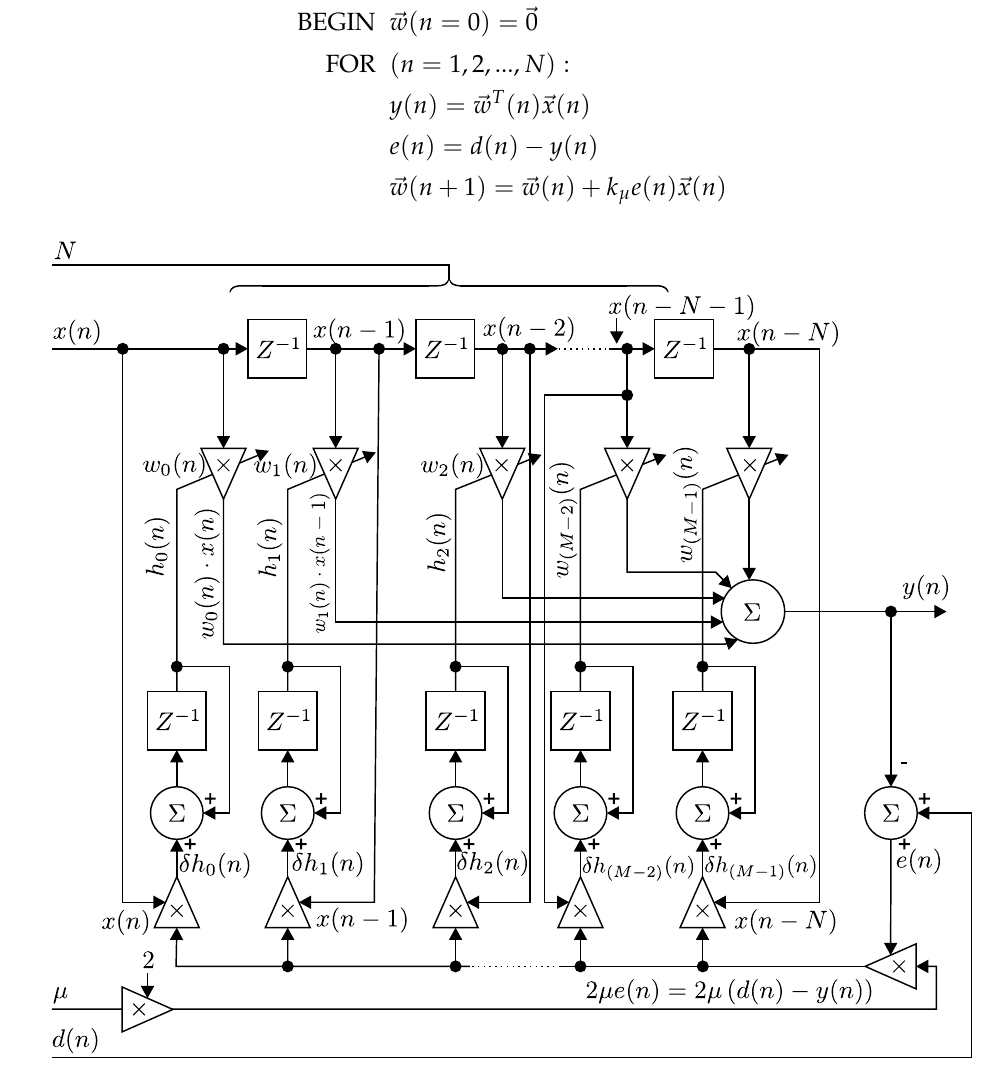
Figure 5. Basic scheme of an adaptive N -th order FIR filter with transversal structure and the LMS